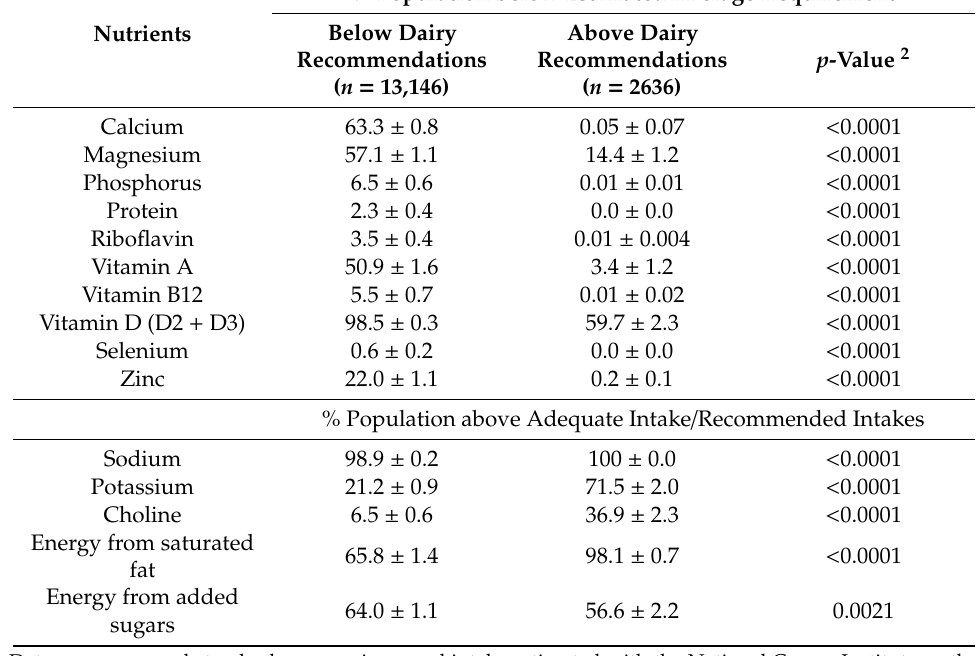
Table 4. Percent U.S. population (ages 2 + , male and female combined) below the Estimated Average Requirement or Above Adequate Intake among those consuming above recommended daily servings of dairy and those consuming fewer than the recommended daily servings of dairy in the National Health and Nutrition Examination Survey 2013–2016 1